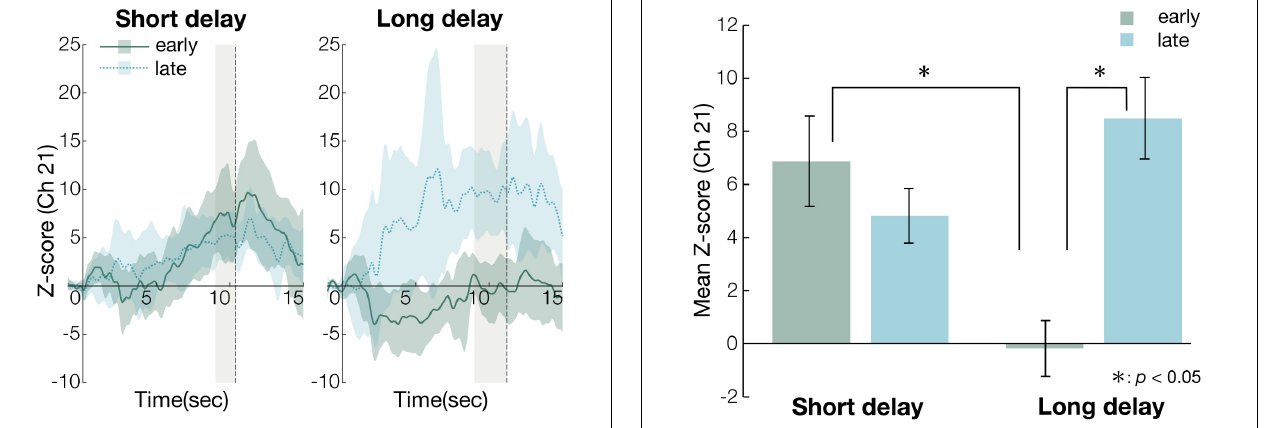
FIGURE 4 | The mean Z-scores of Ch 21 at each condition in the early and the late period. The blue bars represent the mean Z-scores in the statistical analysis time-window (see Figure 3 ) of each condition in the early period, while the green bars represent the mean Z-scores in statistical analysis time-window (see Figure 3 ) of each condition in the late period. The error bar represents standard error. Asterisks indicate the significance level of statistical differences: ∗ p <